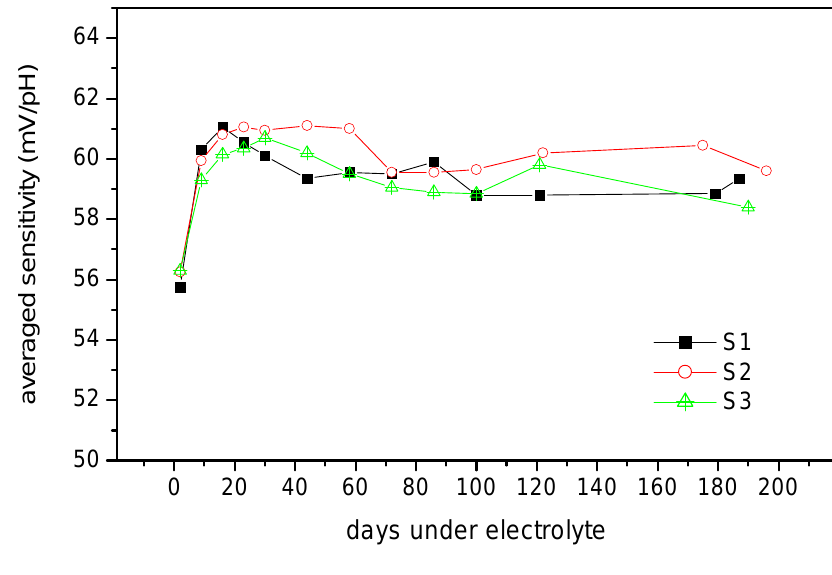
Figure 6. Sensitivities, averaged from pH 9 to pH 4 and from pH 4 to pH 9, of three pH sensors investigated. The substrates of the pH sensors were etched with current densities of 20 mA/cm 2 (S1), 25 mA/cm 2 (S2) and 30 mA/cm 2 (S3),